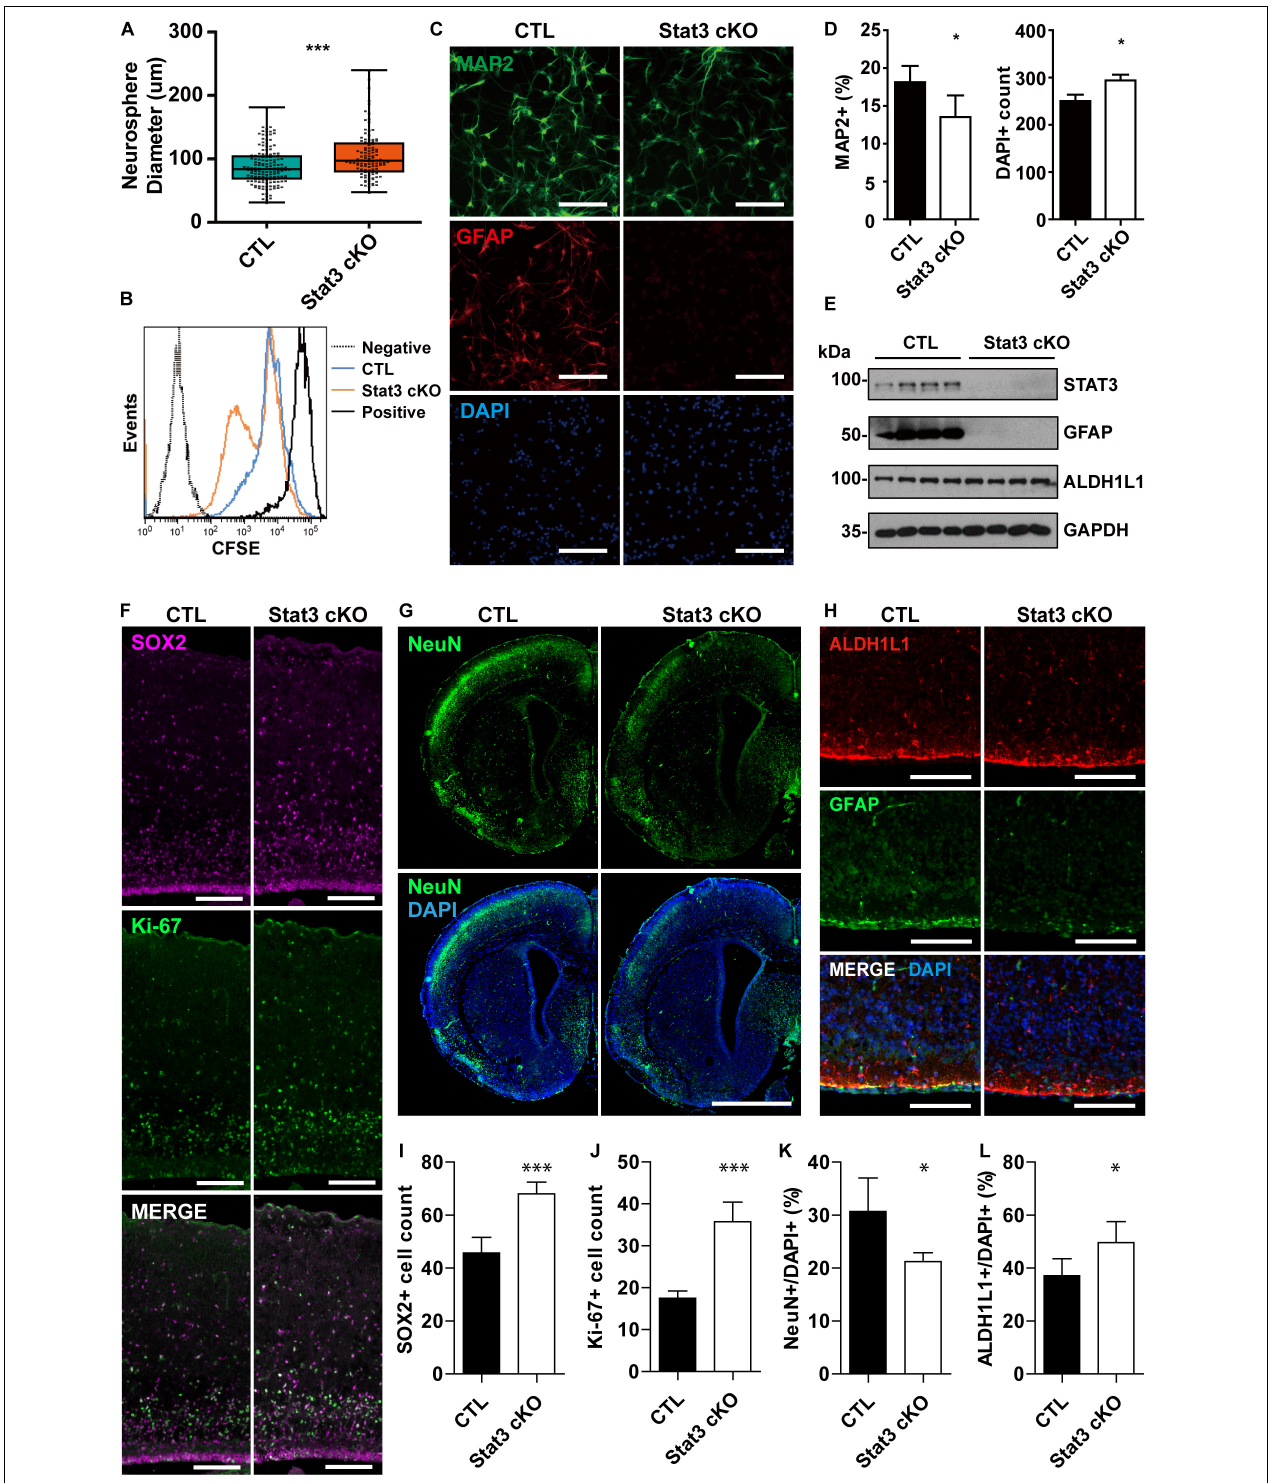
FIGURE 1 | Stat3 cKO in neural progenitors leads to increased proliferation rate and decreased neuronal differentiation. (A) Neurosphere assay showed that Stat3 cKO neural progenitor has a higher proliferation rate. Box plot represents the median, maximum and minimum value as well as the interquartile range. Mann–Whitney test was used to determine the statistical significance. (B) CFSE showed that Stat3 cKO cells divided faster than control cells (C; F/ +). (C,D) Immunofluorescence staining of MAP2 and GFAP in differentiated control and Stat3 cKO neural progenitors. Statistical significance was determined using the student t-test. Error